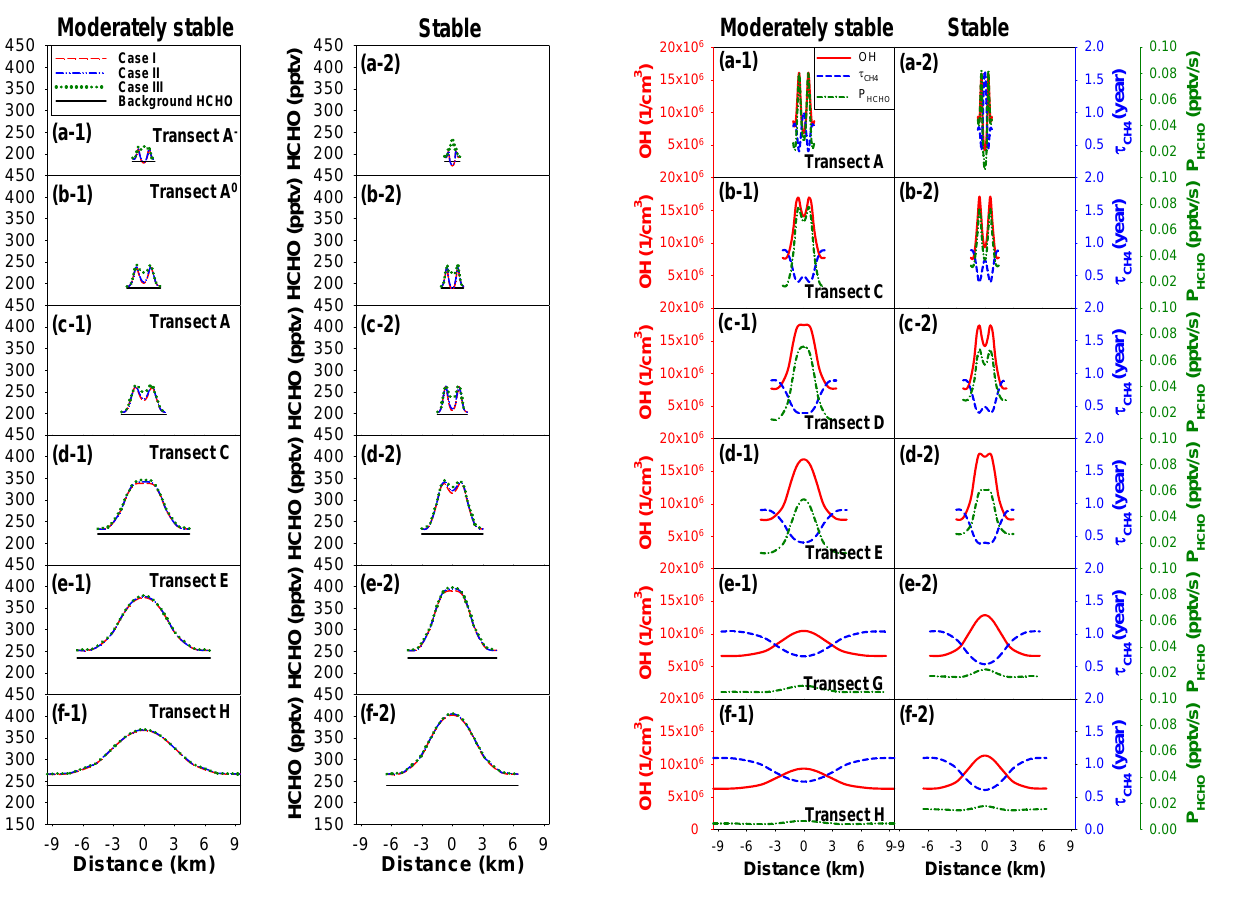
Fig. 5. Profiles of HCHO mixing ratios inside the ITCT 2K2 ship- plume at six transects: (a) transect A − ; (b) transect A ◦ ; (c) transect A; (d) transect C; (e) transect E; and (f) transect H. The first and second columns show the results from the model-simulations under moderately stable (E) and stable (F) MBL conditions, respectively.